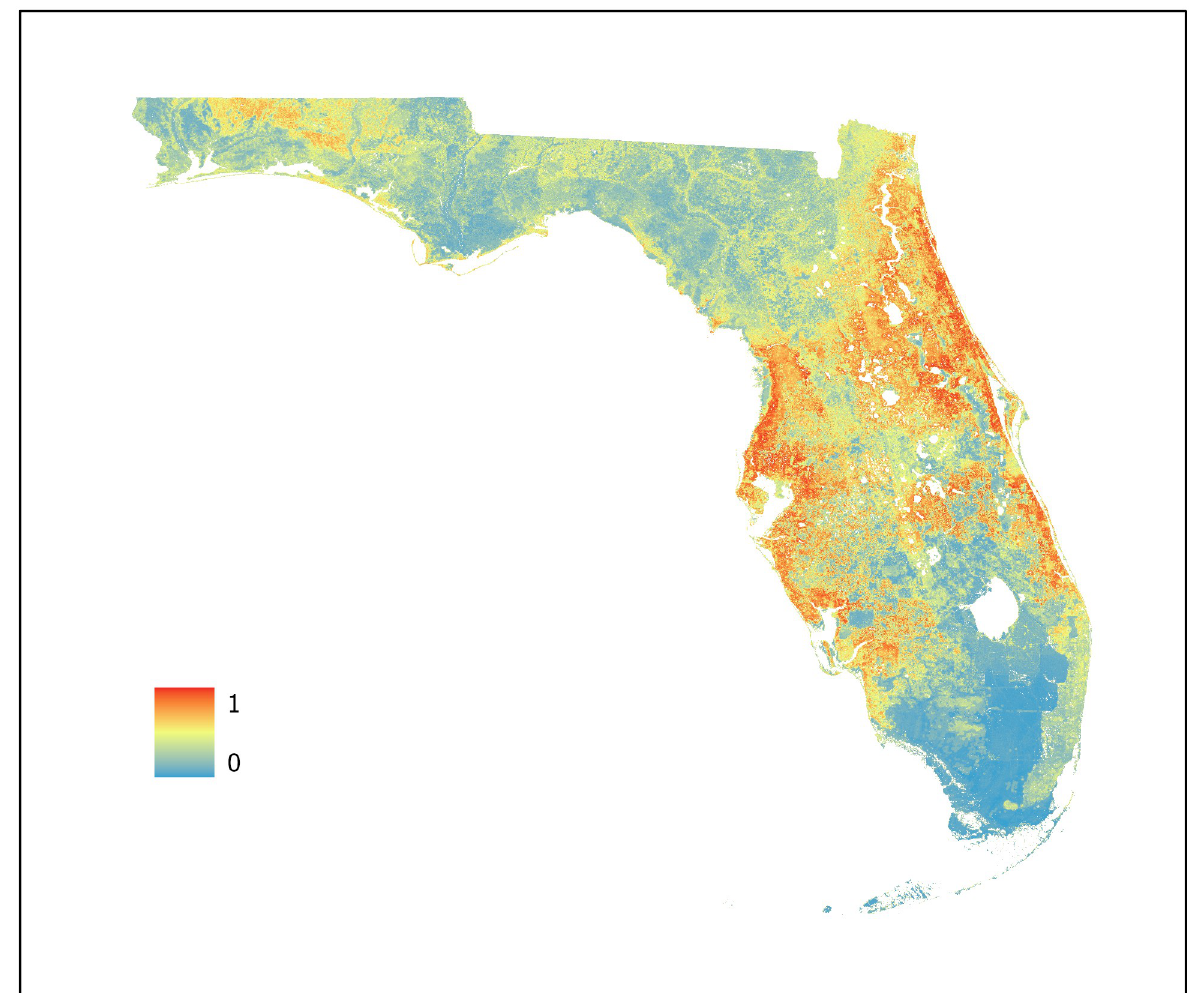
Fig 8. Random forest model. Predictive values range from 0 to 1 with an AUC of 0.9996 (95% CI 0.9988–1.0000).